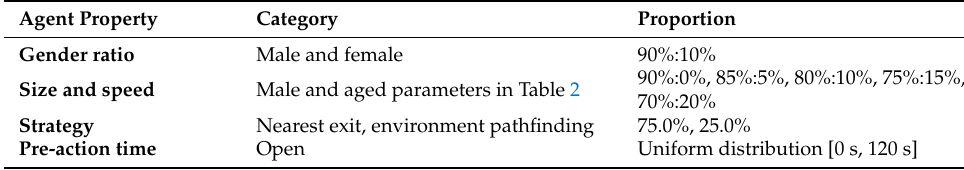
Table 5. Constructor parameters in analysis of age composition’s